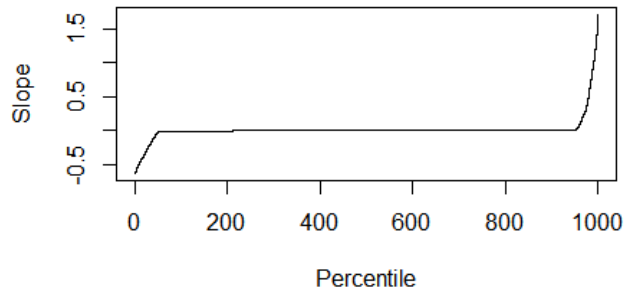
Figure 8. Percentile of the